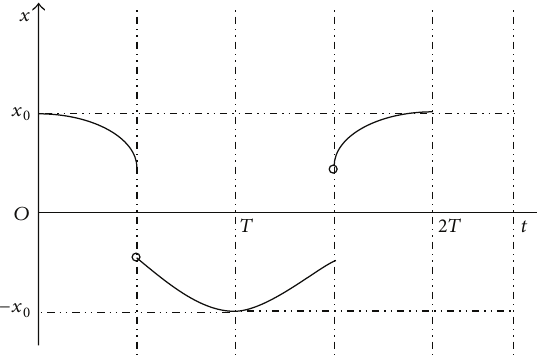
Figure 2: Figure of one-side and two-side orbits.